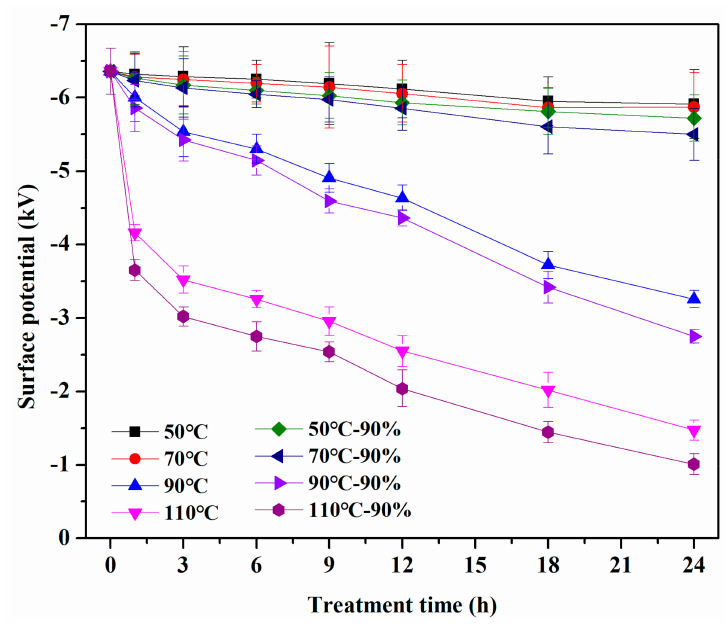
Figure 8. Surface potential decay of melt-blown samples treated by di ff erent